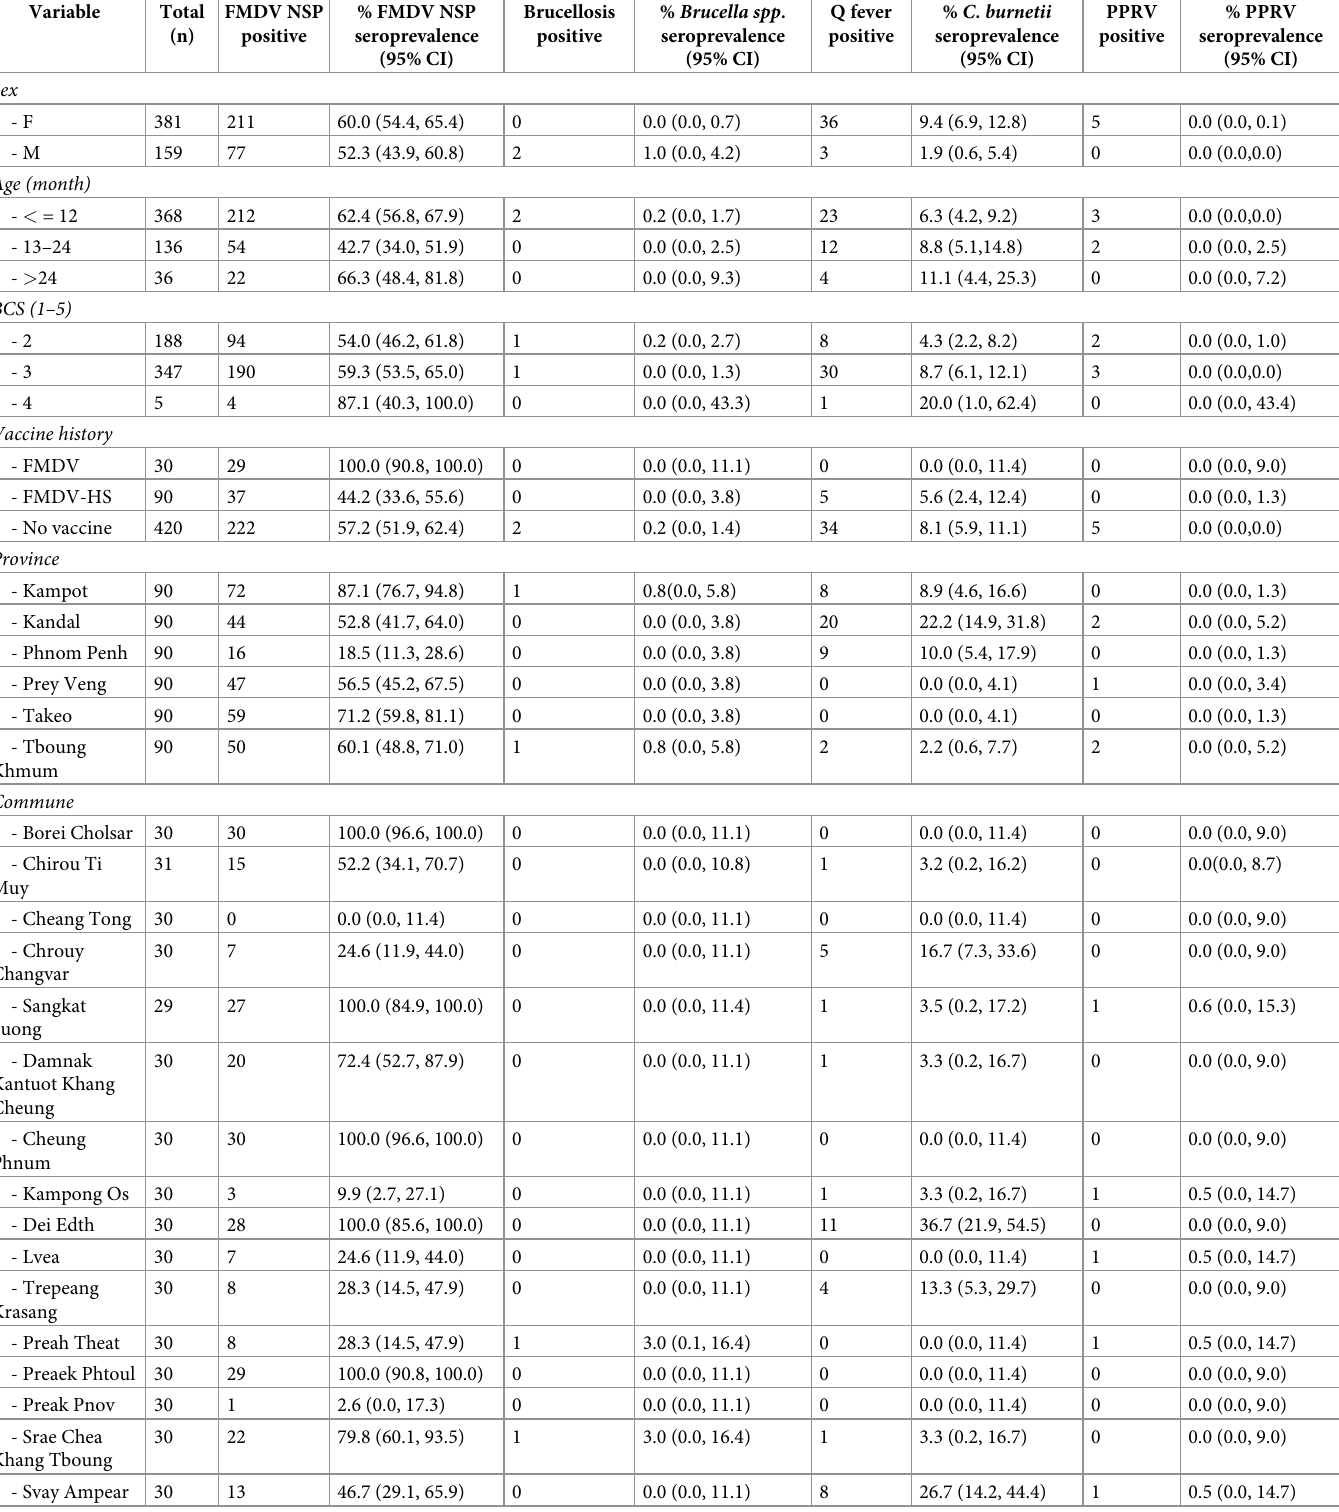
Table 2. Seroprevalences taken into account imperfect tests (True